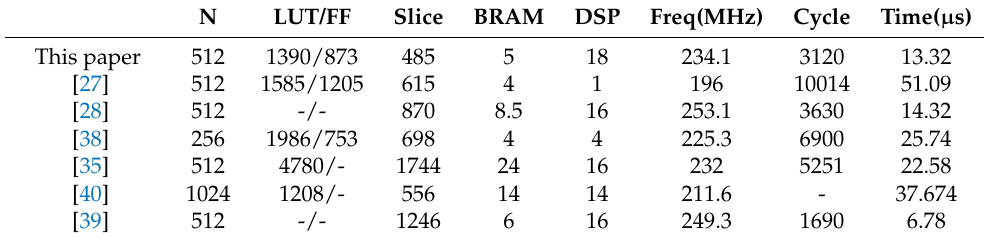
Table 4. FPGA implementation resource comparison of polynomial multipliers.